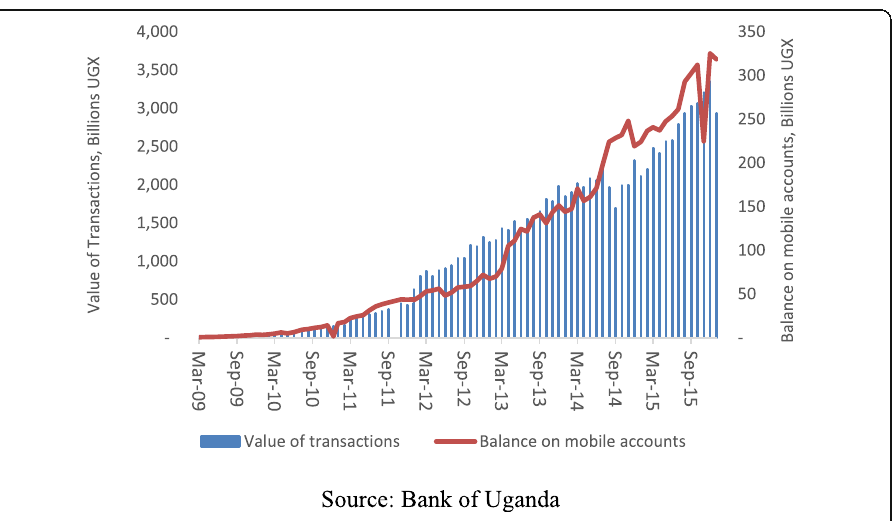
Fig. 1 The volume of mobile money in